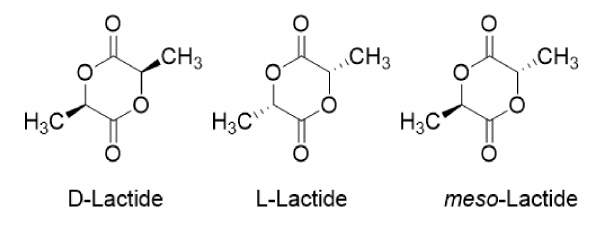
Figure 3. Stereoforms of